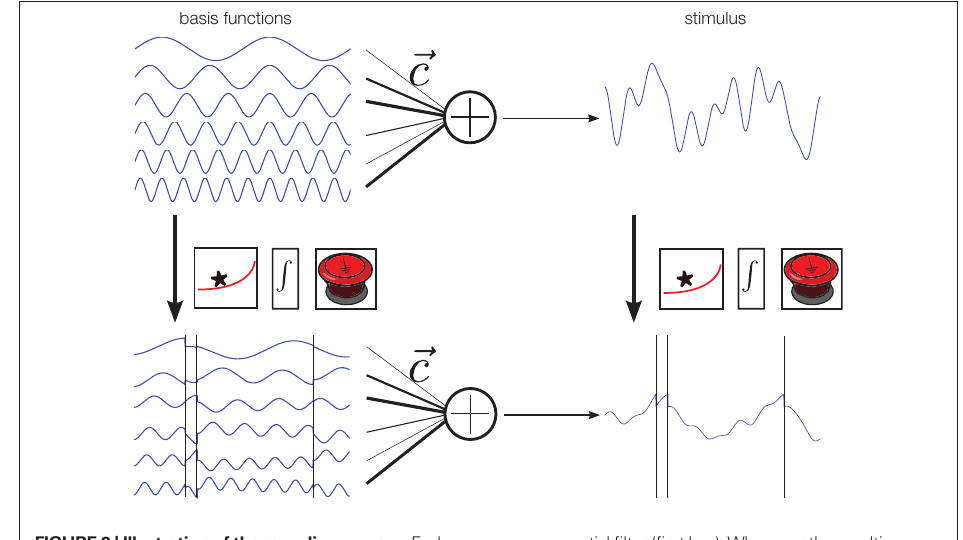
Figure 2 | illustration of the encoding process. Each stimulus is constructed by first drawing random weights c from a Gaussian distribution, and then forming a weighted superposition of basis functions with these weights (top row). This generates a new smooth stimulus on each trial. In our neuron model, the membrane potential at any time is a “leaky” integral of the stimulus. Thus, the membrane potential can be calculated by convolving the stimulus with